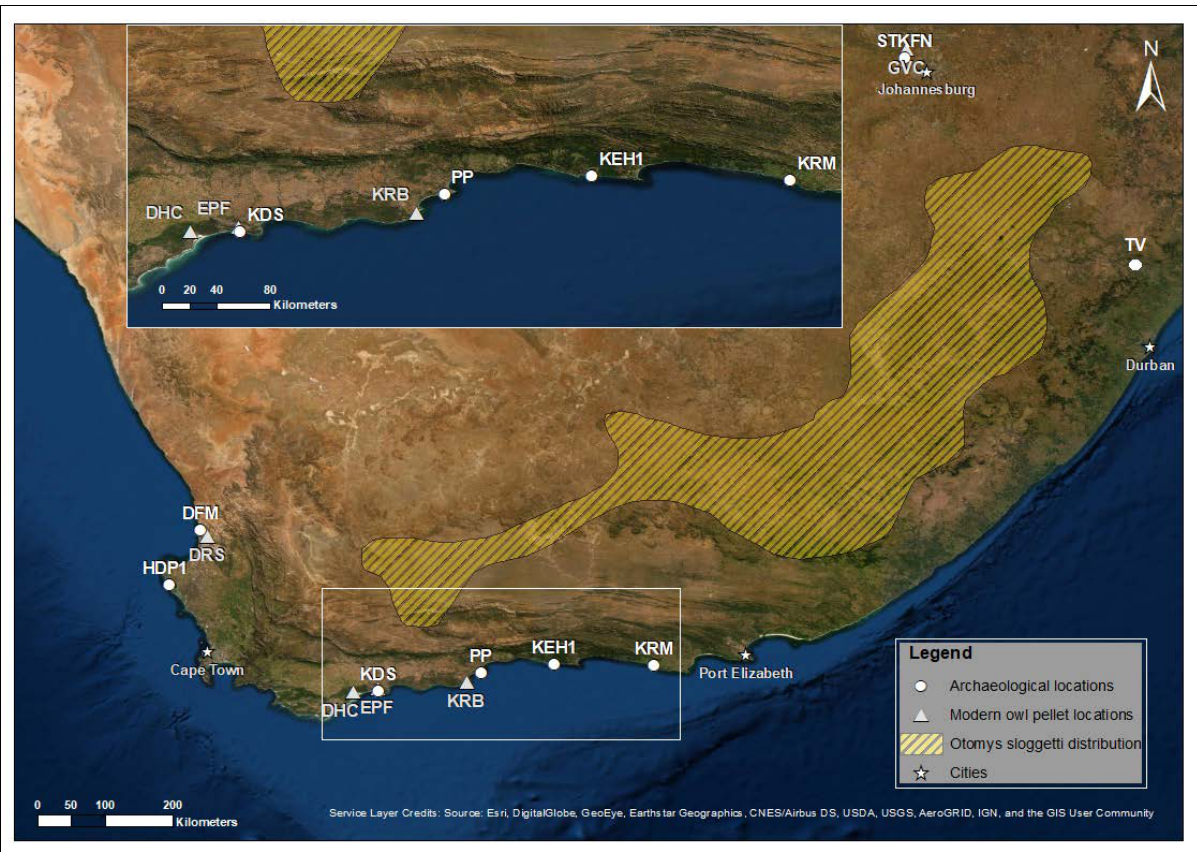
Figure 2: Localities of owl pellet collections and fossil